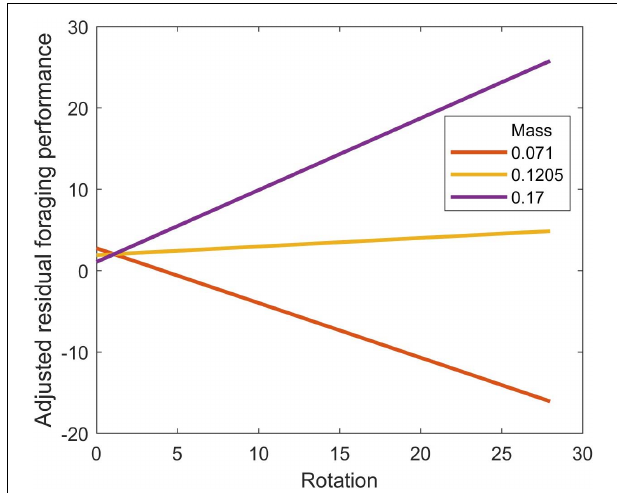
FIGURE 5 | Interaction plot showing the effect of body rotations on residual foraging performance at three levels of body mass (g) for the wolf spider Schizocosa mccooki foraging on flightless Drosophila melanogaster . Residual foraging performance comes from the difference between the actual number of prey eaten and the expected amount eaten from a sex-specific functional response. The sex-specific functional response is shown in Figure 2 and was estimated by bootstrapped fits of the Roger’s Random Predator equation (Eq. 3 in the main text) to male and female data